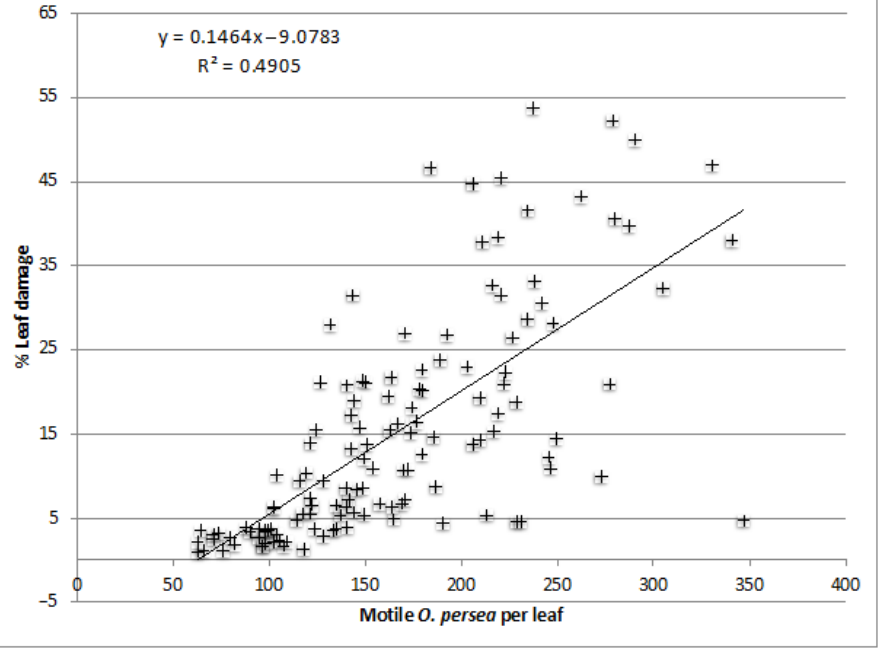
Figure 4. Linear regression for the seasonal (2011–2013) percentage leaf area damage (PLAD) as a function of the maximum motile Persea mite estimated per leaf (2011–2013).